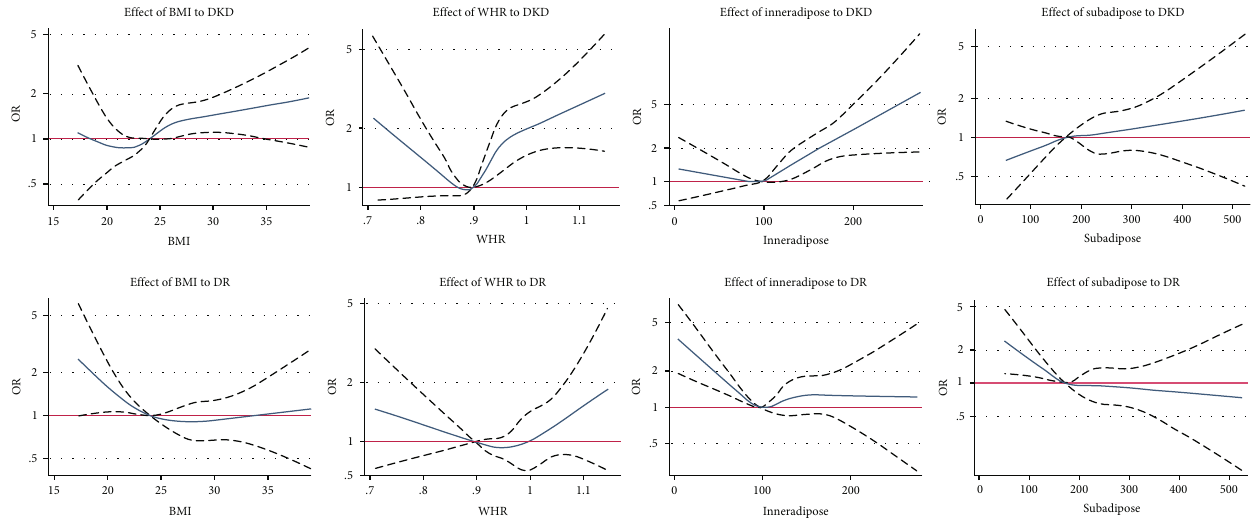
Figure 2: Restricted cubic spline fi gures of obesity indices to DKD and DR using logistic regressions. DKD-OR